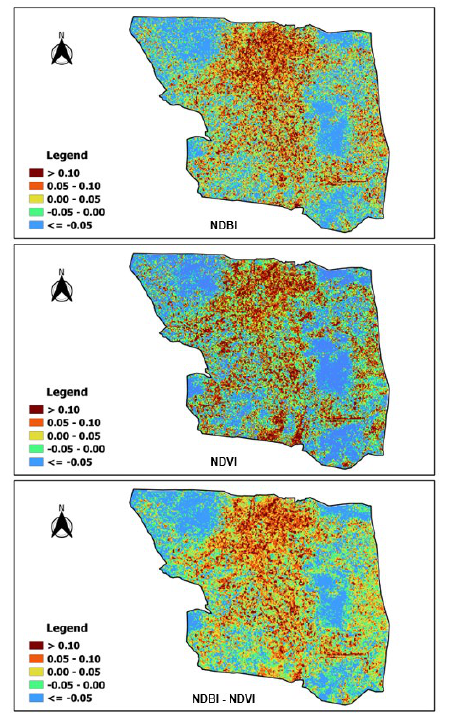
Figure 8. The figure shows the difference between observed and R-F predicted UTFVI values. The figure revealed that overestimated values are usually found in impervious surfaces, whereas underestimated values are mostly found in vegetation areas. A more accurate prediction is obtained when the NDBI and NDVI indices are combined as input data for modelling.